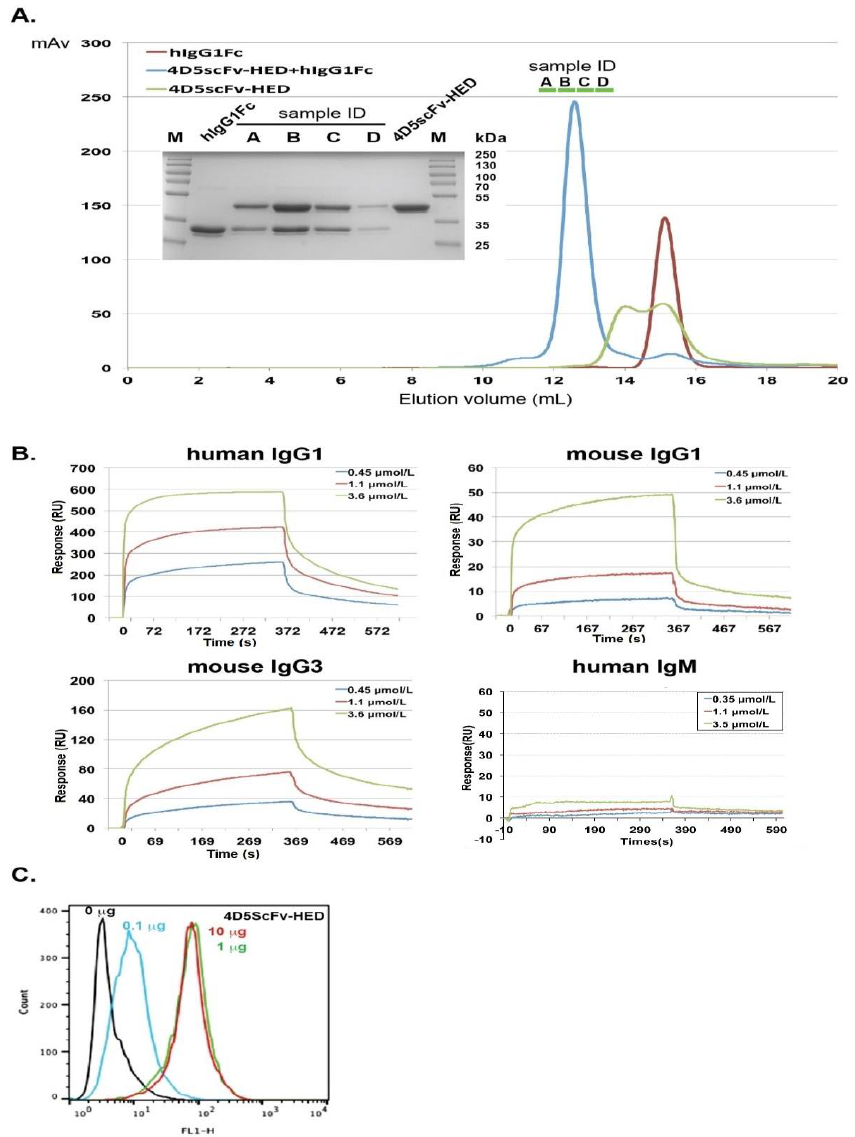
Figure 3. Binding activity of 4D5scFv-HED to intact IgGs or the Fc fragment of IgG1. ( A ) FPLC result shows the fusion protein of the HED domain and 4D5scFv could bind to the Fc fragment of IgG1 in solution. The curves of 4D5scFv-HED, Fc fragment, and their complex are colored in green, red, and blue, respectively. Insert: For each fraction of the peak, a 20 µ L sample was loaded on a 12% SDS-PAGE, and coomassie brilliant blue staining solution was used to visualize the proteins. ( B ) Biacore assay to determine the binding of the fusion protein of HED and 4D5scFv to human IgG1, mouse IgG1, mouse IgG3, and human IgM. ( C ) FACS assay shows the binding of 4D5scFv-HED to T6-17 cells. After being washed by FACS buffer, cells were incubated without or with different concentrations of the fusion protein 4D5scFv-HED for 30 min followed by washing and incubation with FITC-labeled goat immunoglobulin, and then the cells were analyzed on a flow cytometer.